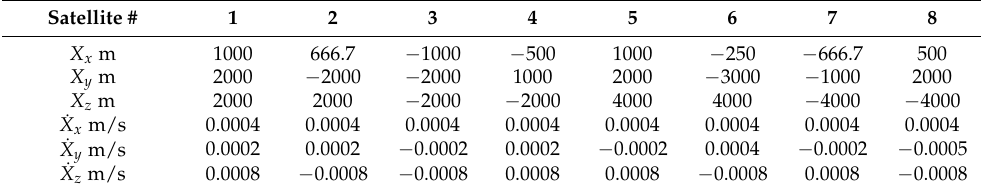
Table 1. Initial conditions for 8 satellites.